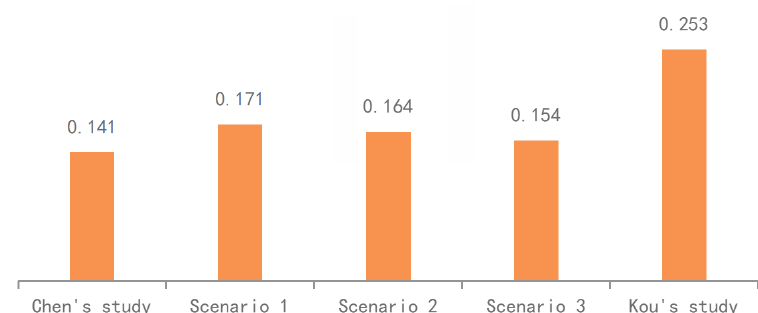
Figure 12. Comparison of integrated carbon emission reduction factors.